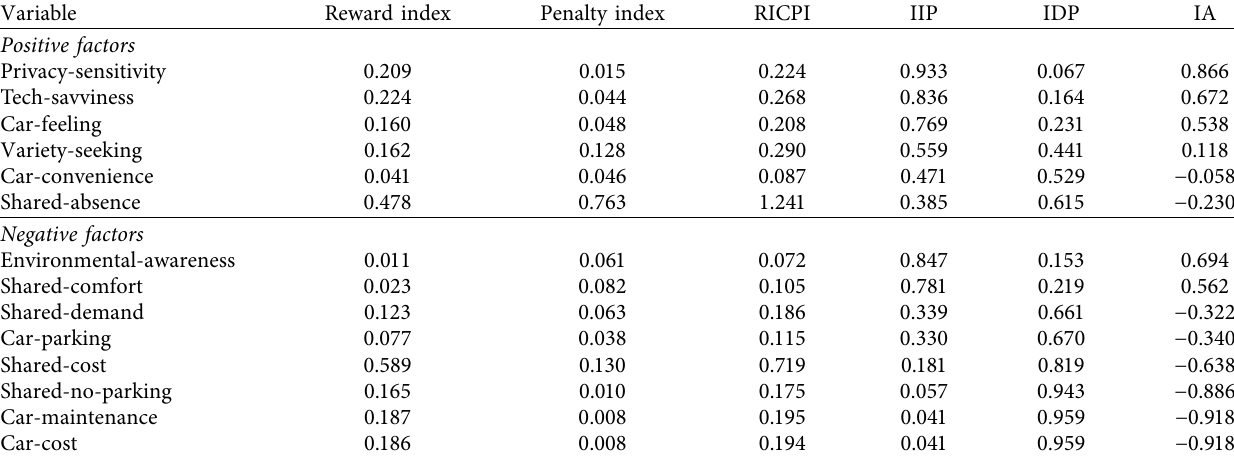
Table 5: The IA indexes of attitudinal factors influencing the pre–COVID-19 car purchase intention.